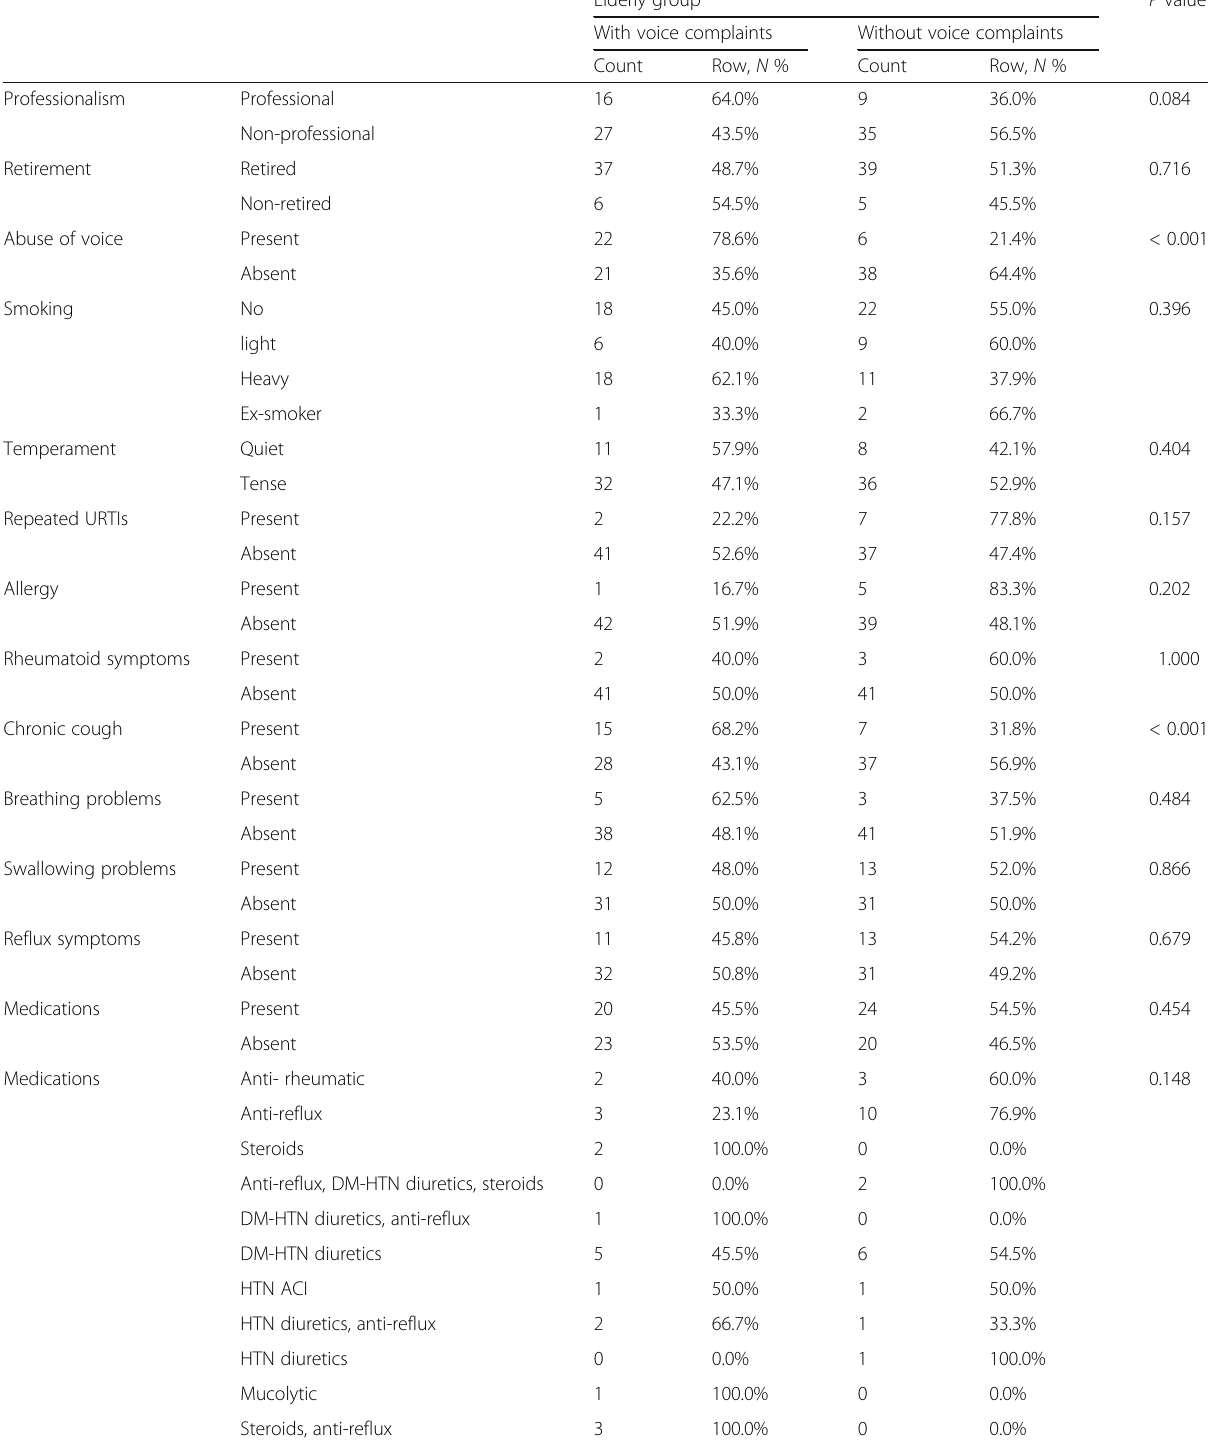
Table 4 Frequency of potential vocal health hazards and general medical comorbidities among all studied population Elderly